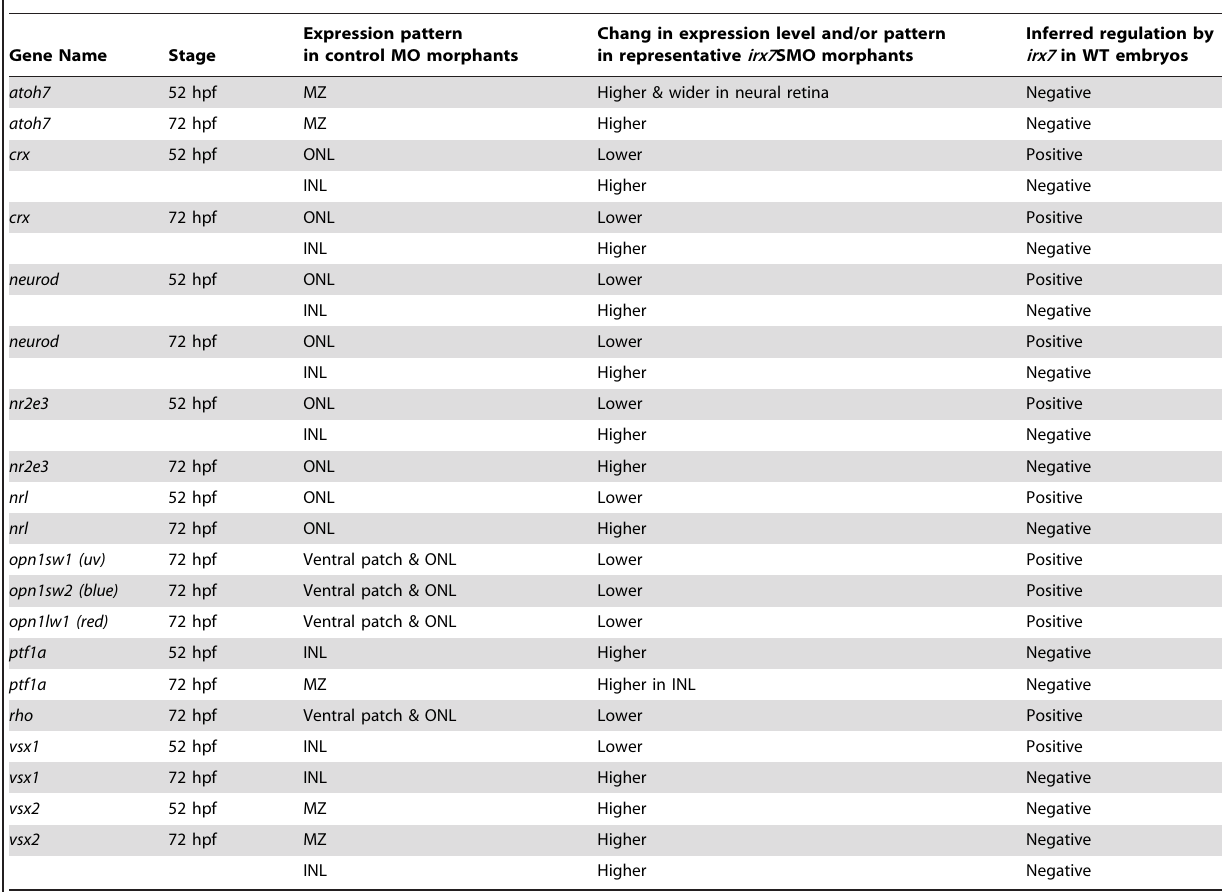
Table 1. The change in the expression level and/or pattern of target genes in Irx7 knockdown